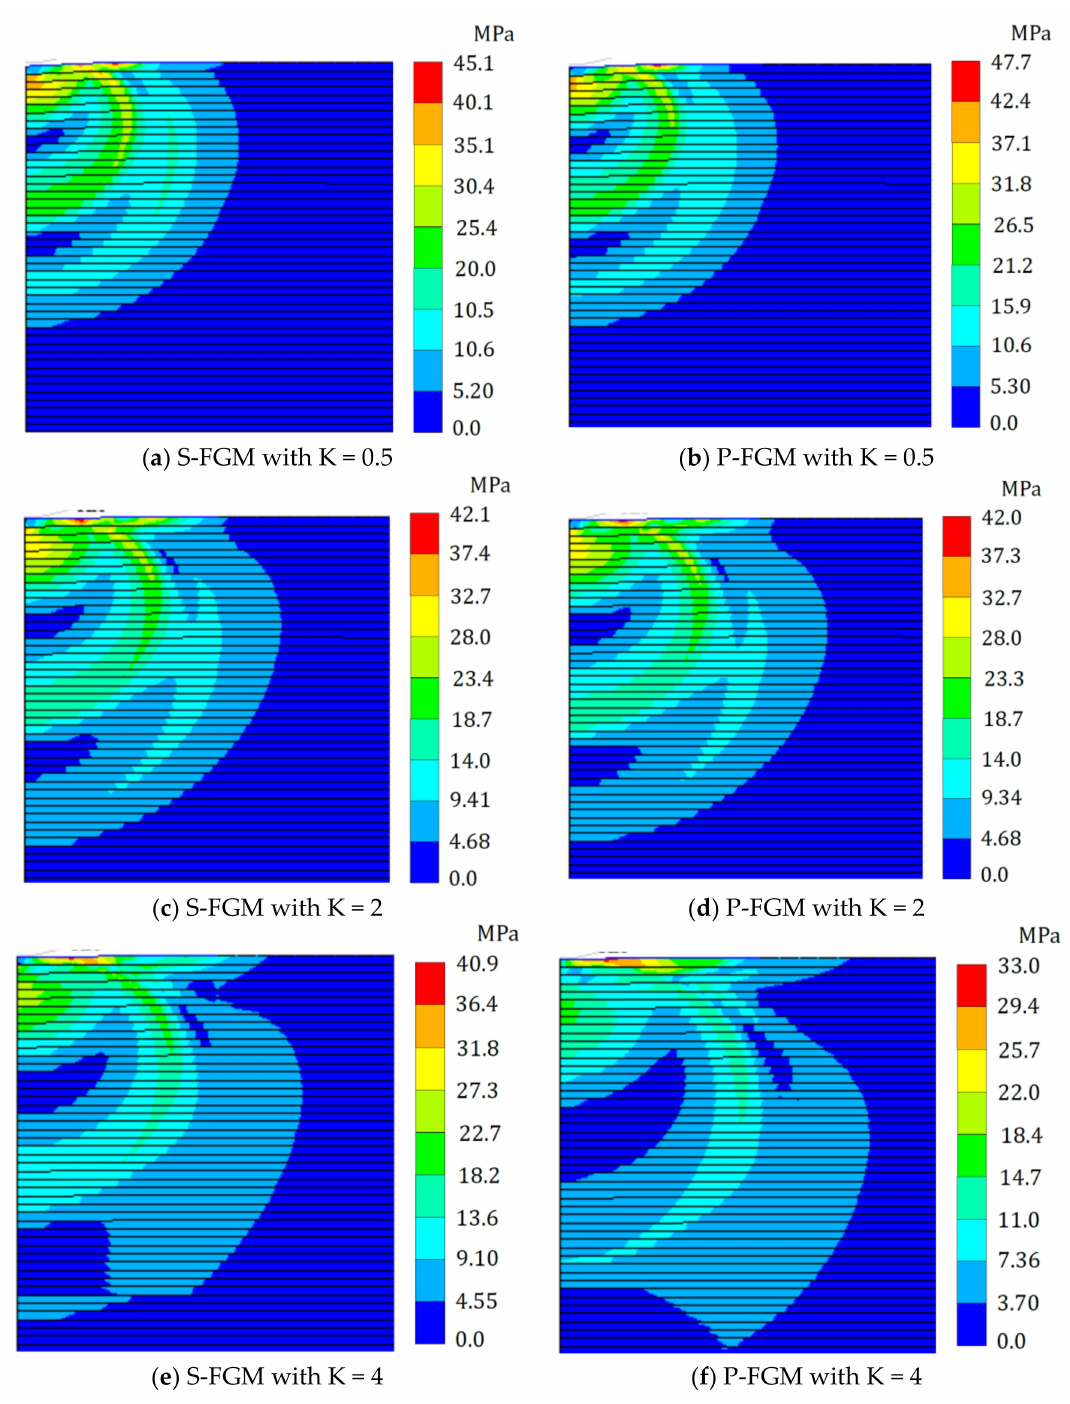
Figure 11. Distributions of the residual von Mises equivalent stress (after unloading) within the elastoplastic Ti/TiB specimen at different gradient indices; ( a ) the residual von Mises equivalent stress of S-FGM at K = 0.5, and ( b ) the residual von Mises equivalent stress of P-FGM at K = 0.5. ( c ) the residual von Mises equivalent stress of S-FGM at K = 2, and ( d ) the residual von Mises equivalent stress of P-FGM at K = 2. ( e ) the residual von Mises equivalent stress of S-FGM at K = 4, and ( f ) the residual von Mises equivalent stress of P-FGM at K =